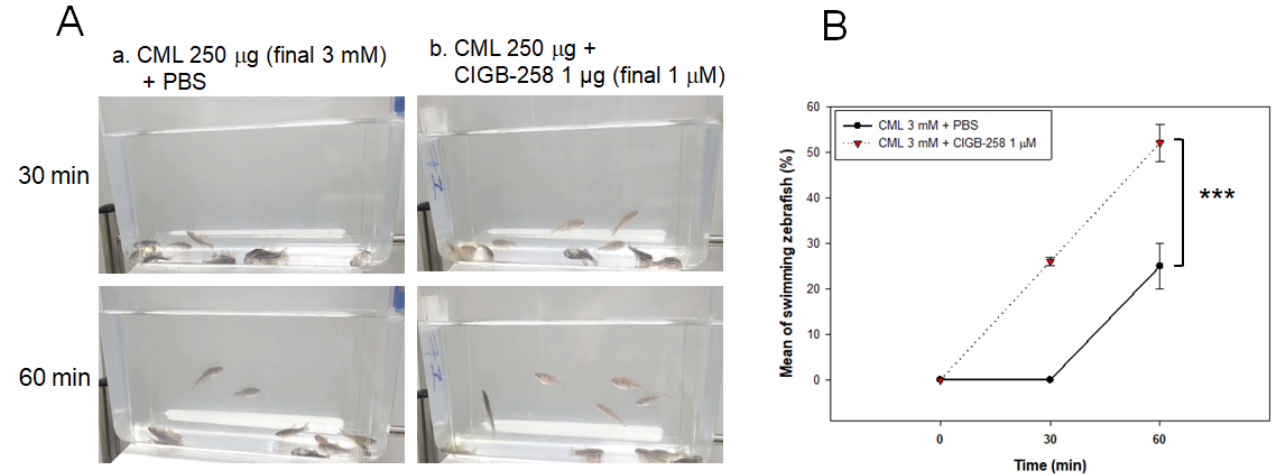
Figure 5. Comparison of the swimming ability after injection of carboxymethyllysine (CML) with or without CIGB-258. ( A ) Still image of swimming pattern of zebrafish after 30 min and 60 min post-injection of CML (250 μ g) + PBS (photo a) and CML (250 μ g) + CIGB-258 (1 μ g, photo b) per fish. ( B ) Percentage of swimming zebrafish after 30 min and 60 min post-injection of CML (250 μ g) + PBS and CML (250 μ g) + CIGB-258 (1 μ g). ***, p < 0.001.